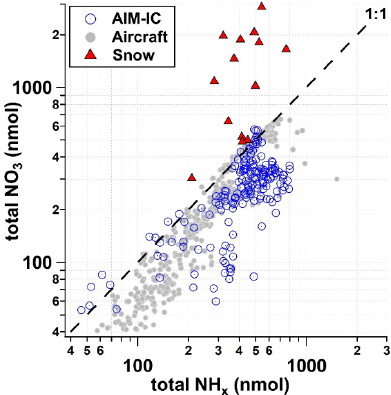
+ HNO Figure 6. Total NO 3 ( p NO − 3 ) with respect to total NH x 3 measured and predicted from AIM-IC data (grey circles), aircraft measurements (open blue circles) per cubic metre of ambient air and snow (red triangles) within 0.008m 2 sampling area from 21 January to 3 February 2017.